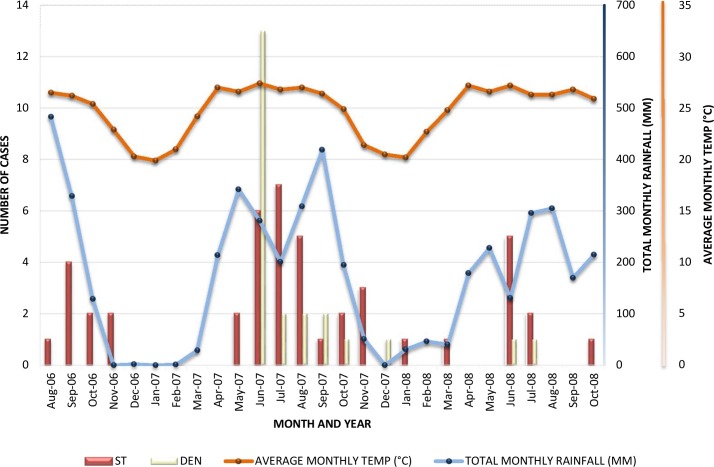
The temporal spread of scrub typhus and dengue cases and monthly meteorological data for Mueang district, Chiangrai province (Thai Meteorological Department, Chiangrai).